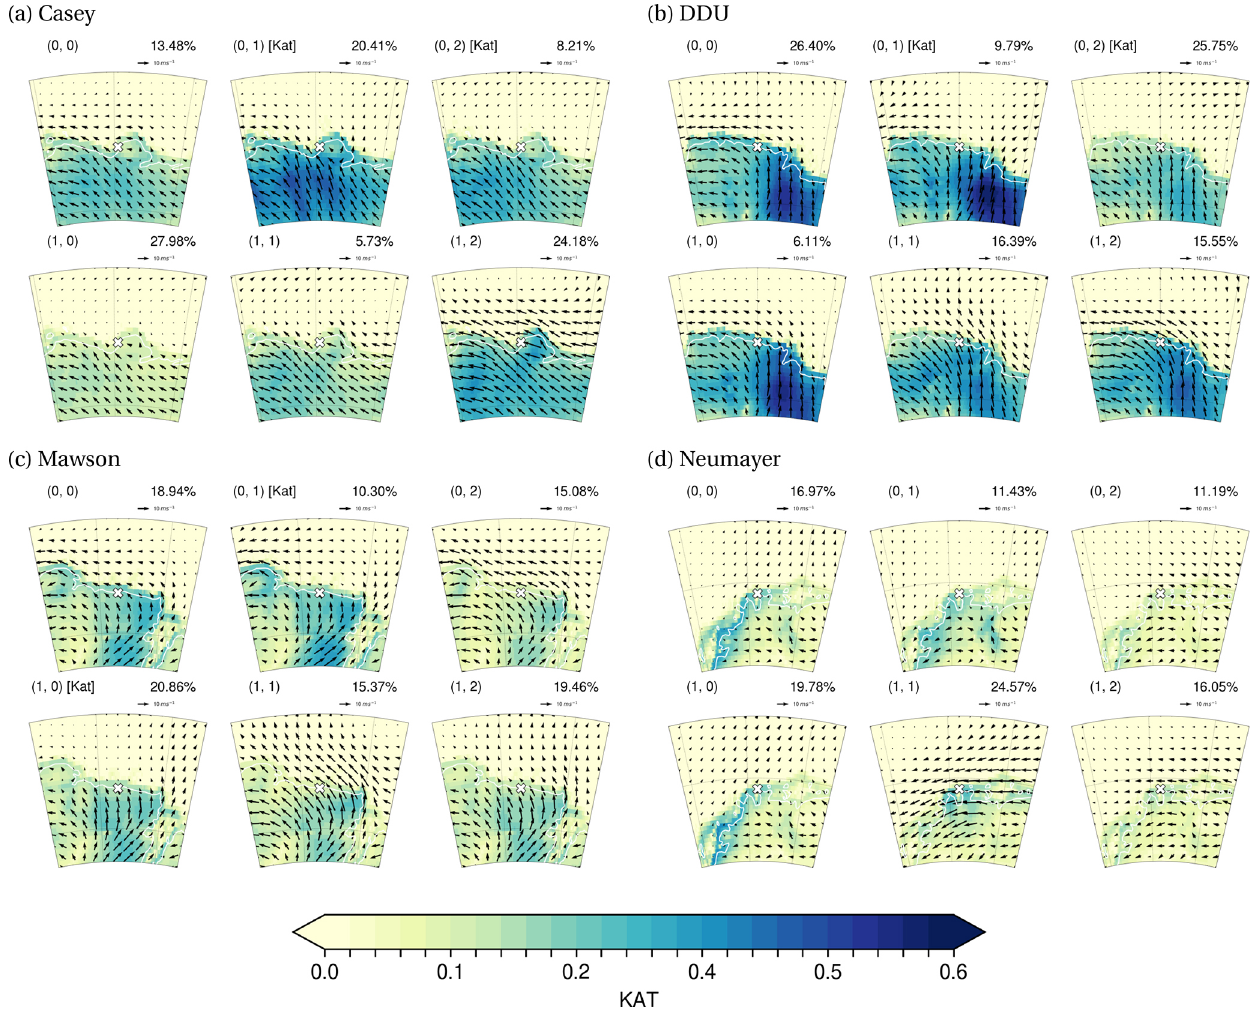
Figure 6. Composited ERA5 katabatic acceleration term with 10m wind vectors overlain for each node at (a) Casey, (b) DDU, (c) Mawson and (d) Neumayer from SOMs calculated for the period 2010–2017. Station locations are marked as a white cross. Nodes with limited synoptic forcing but favourable conditions for katabatic forcing are labelled with a